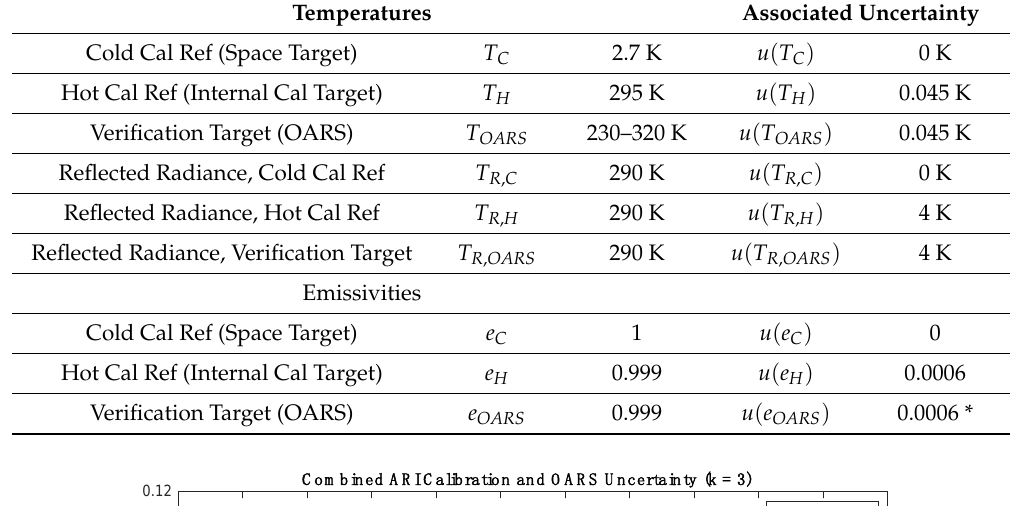
Figure 5. Predicted on-orbit radiometric calibration uncertainty (dashed) and calibration verification source uncertainty (solid) (k = 3).